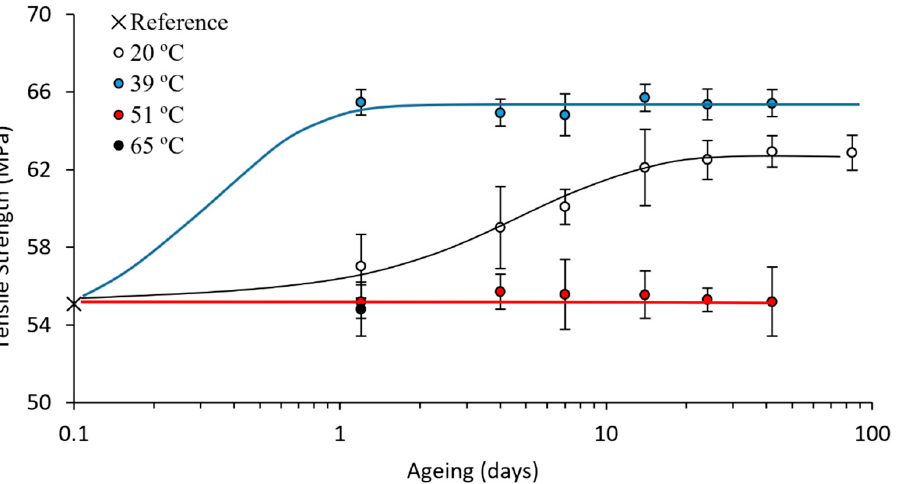
Figure 6. Tensile strength evolution with ageing time at different ageing temperatures. Logistic fittings for 20 and 39 ° C, linear fitting for 51 ° C. These fittings correspond to Equations (2), (4), and (6), respectively.